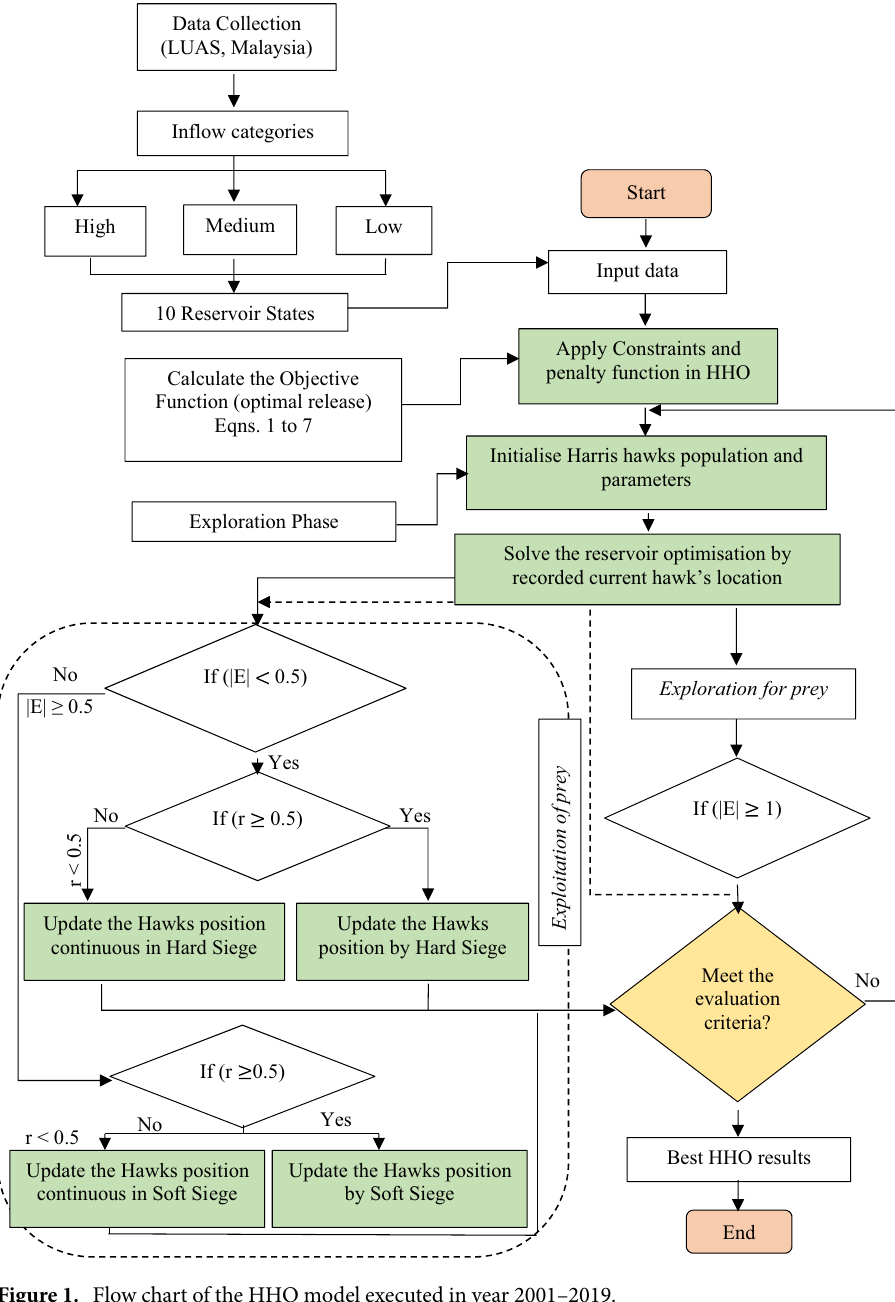
Figure 1. Flow chart of the HHO model executed in year